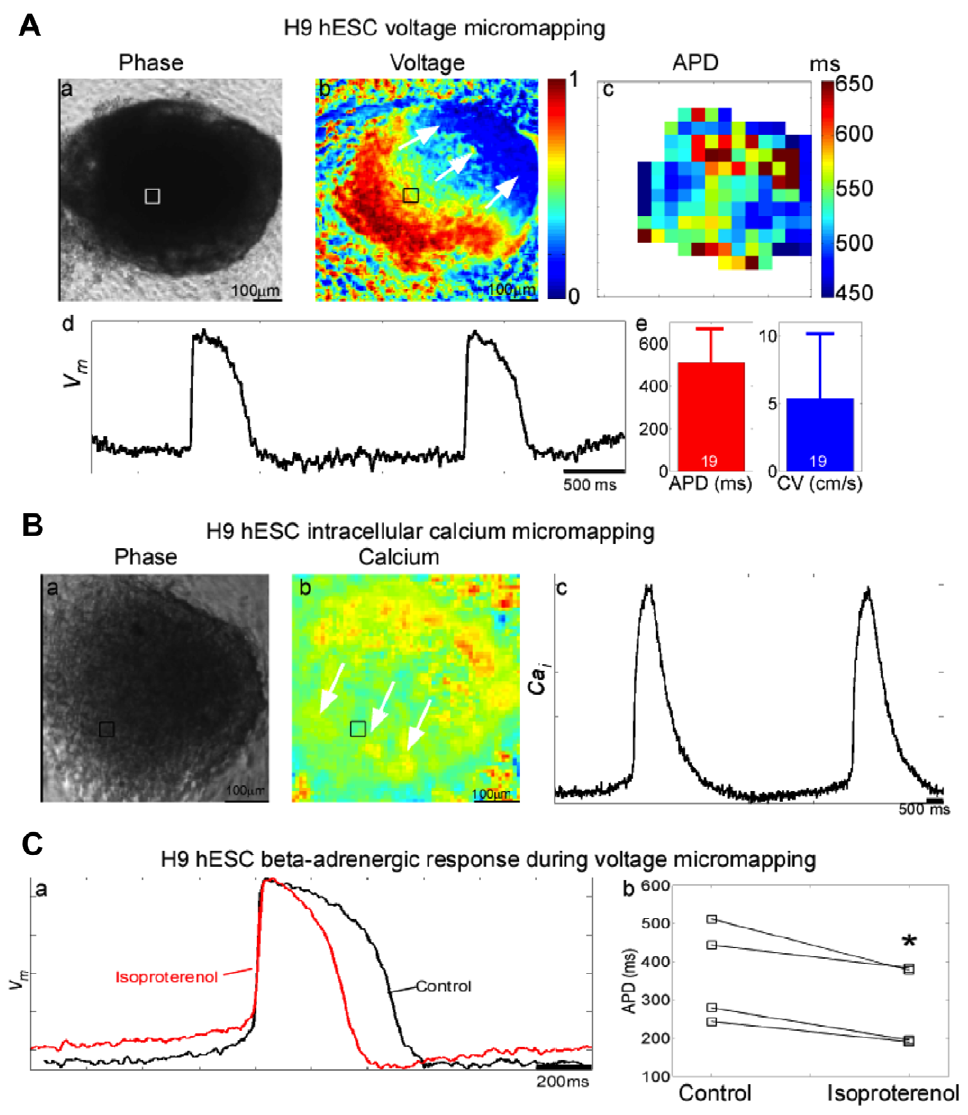
Figure 7. Electrophysiological characterization H9 hESC contracting hEB using optical mapping. ( A ) Voltage micromapping. a, Phase contrast image of H9 hEB at 4 6 magnification. b, Voltage activation map (arrows indicate direction of electrical wave propagating across hEB). c, Action potential duration (APD) map. d, Representative transmembrane potential (V m ) trace at position denoted by the small square in a and b during 0.5 Hz field stimulation. e, Mean APD and conduction velocity (CV) measurements from 19 hEB (error bars represent 6 s.d.). Coefficient of variation (COV, population s.d. divided by mean) for APD was 0.30 and for CV was 0.88 across hEB population. COV within an individual hEB was calculated from multiple APD measurements across all of the recording sites for that hEB (panel A, c) and was 0.042 6 0.030 (s.d.) when averaged across 19 hEB. ( B ) Intracellular calcium micromapping. a, Phase map of hEB at 6 6 magnification. b, Calcium map (arrows indicate direction of propagating calcium wave). c, Representative intracellular calcium (Ca i ) trace at position denoted by the box in a and b. ( C ) The beta-adrenergic agonist isoproterenol shortened the mean APD in all 4 hEB by an average of 23 6 8 ms (mean 6 s.d.). * indicates p < 0.01 in a paired Student’s t-test.